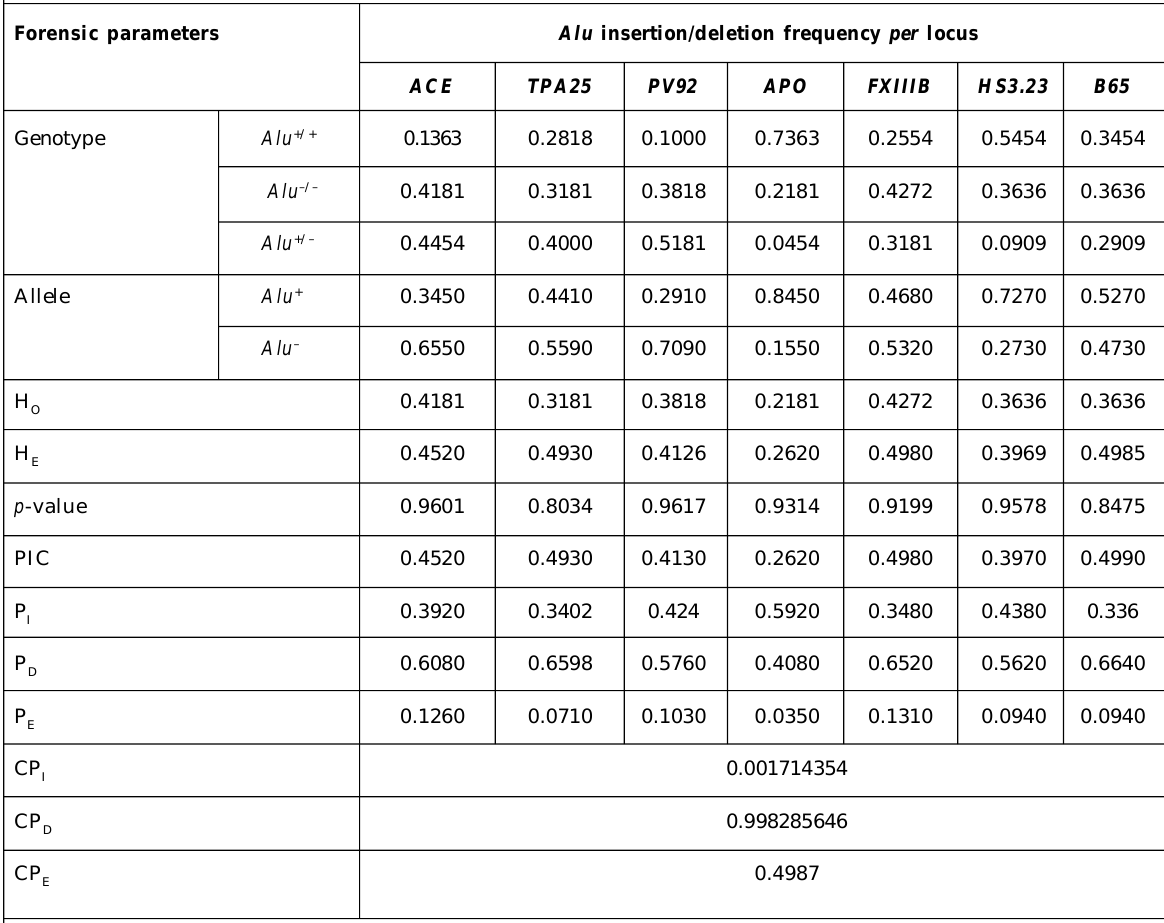
Table 2: Genotypic, allelic frequencies and forensic indices of the insertions and deletions of the Alu DNA fragment per seven genomic loci in 110 unrelated Jordanian individuals Forensic